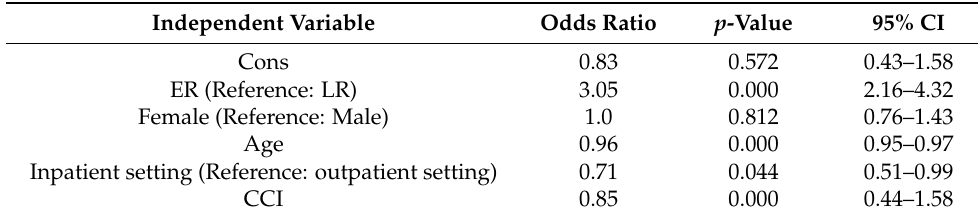
Table 3. Results of the multivariate logistic regression model (outcome: HD or